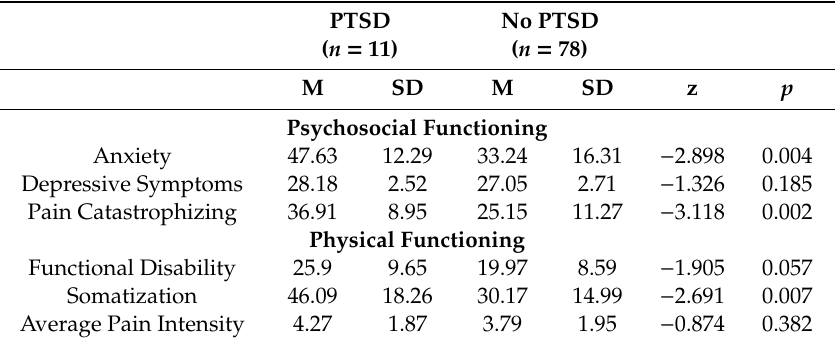
Table 2. Variability in variables across PTSD groups (baseline / Time